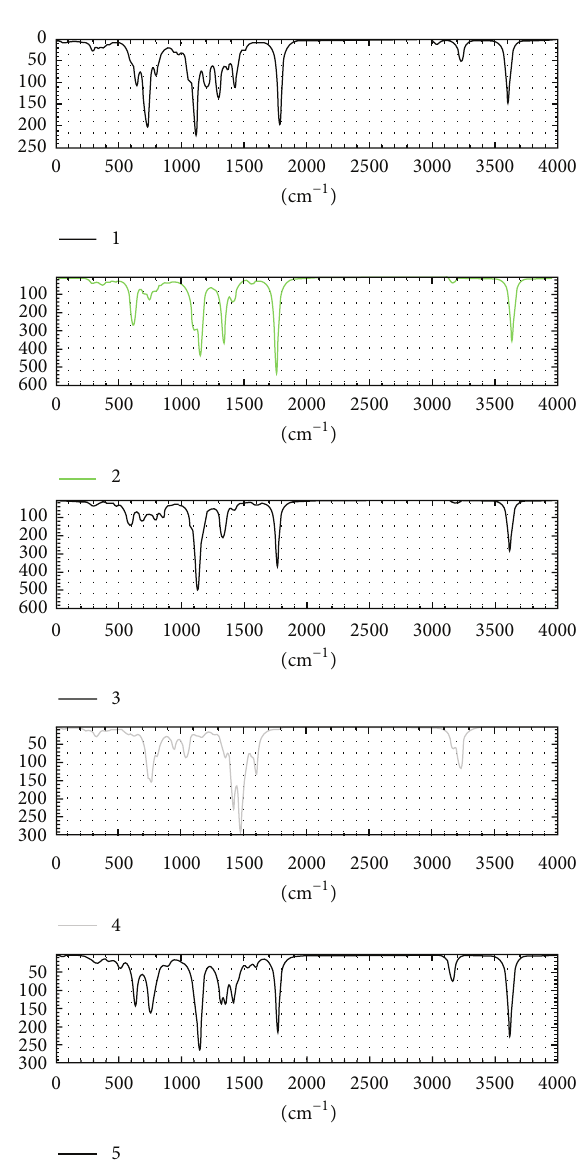
Figure 2: The IR spectra of the indicated complexes showed the variation in their vibrational